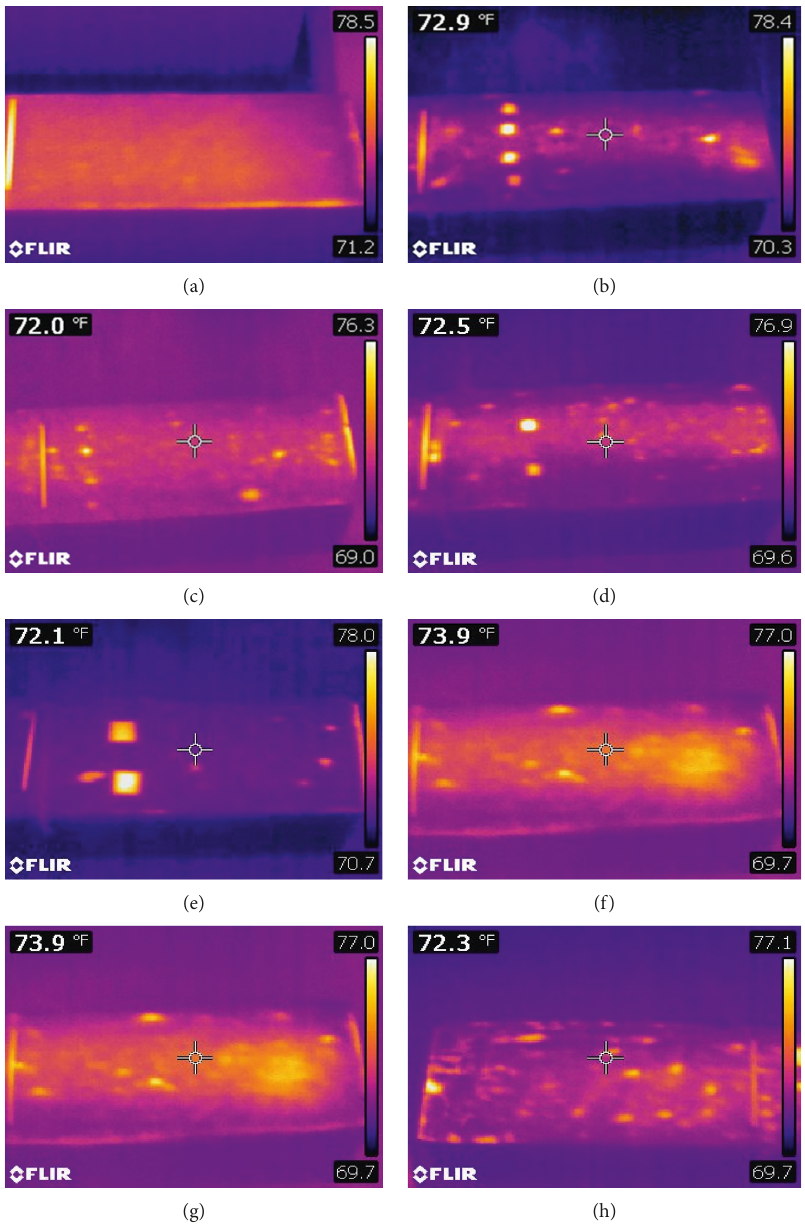
Figure 12: Thermographs of samples. Note. ° C � ( ° F − 32 ) ∗ 5/9. (a) Control sample 2. (b) Sample 3. (c) Sample 4. (d) Sample 5. (e) Sample 6. (f) Sample 7. (g) Sample 9. (h) Sample